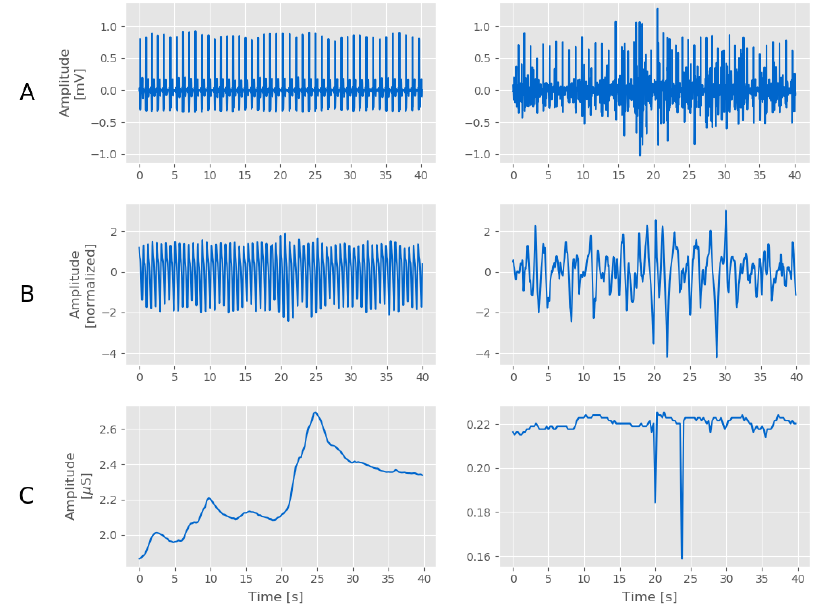
Figure 2. Portions of signals from wearable devices (WDs) extracted from the Wearable and Clinical Signals (WCS) dataset to show examples of high (left column) and low (right column) quality signals. ( A ): electrocardiogram (ECG) signals collected by the HeartBand; ( B ) blood volume pulse (BVP) signals collected by the E4; ( C ) electrodermal activity (EDA) signals collected by the